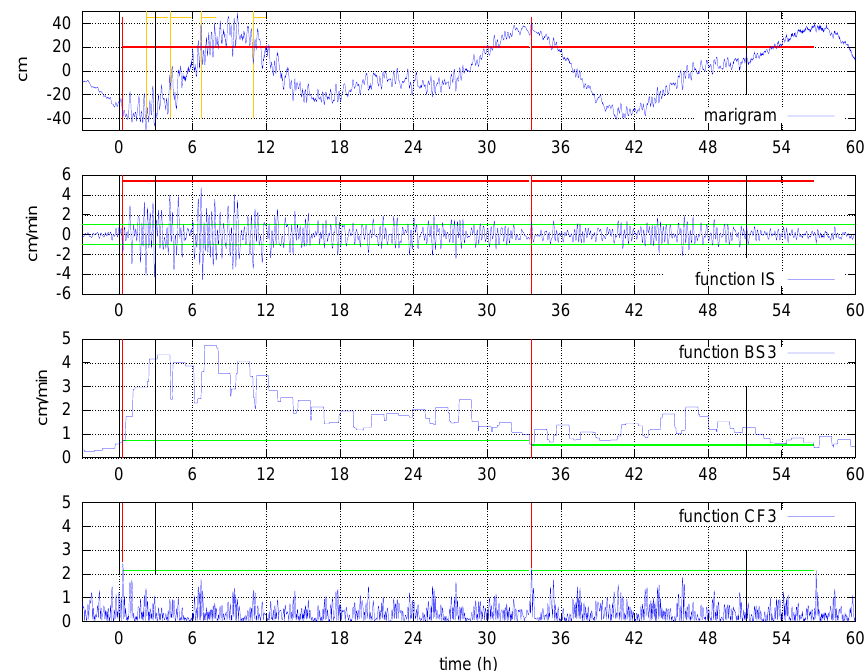
Fig. 2. Example of TEDA functions for the record of the Kuril Islands 2006 tsunami at the Adak tide gauge. Method used A3: t IS = 10min, t G = 15min, t BS = 60min, λ IS = 1cmmin − 1 , λ CF = 2 . 15. Sampling interval is 1min. From top to bottom: sea level original record, IS( t ), BS3( t ), and CF3( t ). Time is counted starting from the tsunami arrival time ( t = 0). In every panel, detections of tsunami are indicated with vertical red lines. In the first panel showing the recorded marigram, it also shows the tsunami state duration (red horizontal line), the secure detections (orange vertical lines), the secure alert duration (orange horizontal lines), and the end of the tsunami signal (black vertical lines). Notice that, soon after the first tsunami state ends (about 33.6h), a new detection is triggered and the corresponding tsunami state lasts for about 24h more. Horizontal green lines in the IS and CF3 function panels indicate the corresponding thresholds λ IS and λ CF , while in the BS3 panel they indicate the values assumed by BS3 at the detection